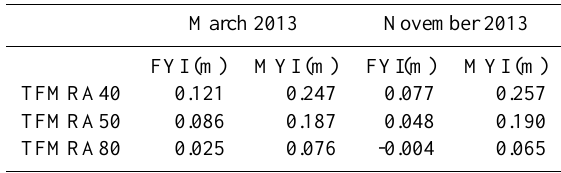
Figure 8. Probability density functions corresponding to Fig. 7b. For the comparison only valid data from coincident coverage are considered.